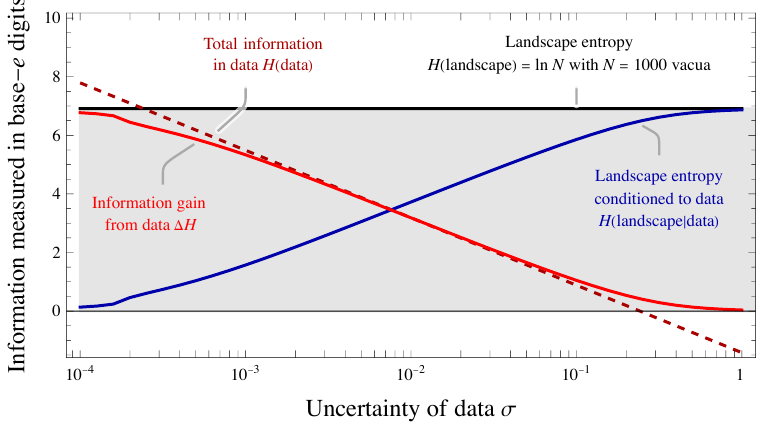
Figure 7 . We consider a toy landscape with N = 1000 vacua, so that the black horizontal curve at H (landscape) = ln 1000 shows the Shannon landscape information entropy. This progressively decreases down to H (landscape | data) as fundamental parameters are measured with smaller uncer- tainty σ (blue curve). The information gain ∆ H = H (landscape) − H (landscape | data) from data (red curve) agrees with the landscape-independent amount of information in data H (data) (dashed red curve) in the intermediate region where the landscape is only partially